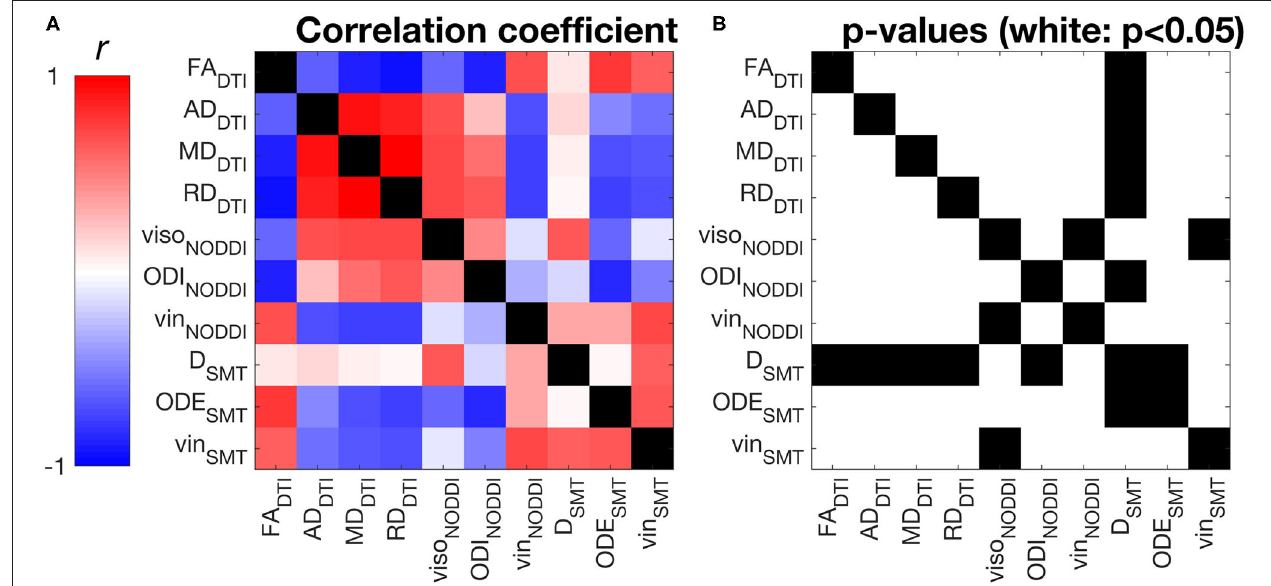
FIGURE 4 | Pearson’s linear correlation among all possible pairs of MRI metrics from DTI, NODDI and SMT. (A) correlation values illustrated as a 2D symmetric matrix (note its symmetry with respect to the diagonal) and calculated using the normal-appearing white matter (NAWM) mean values of the metrics (white matter for controls). (B) statistically significant correlations, highlighted in white ( p < 0.05).